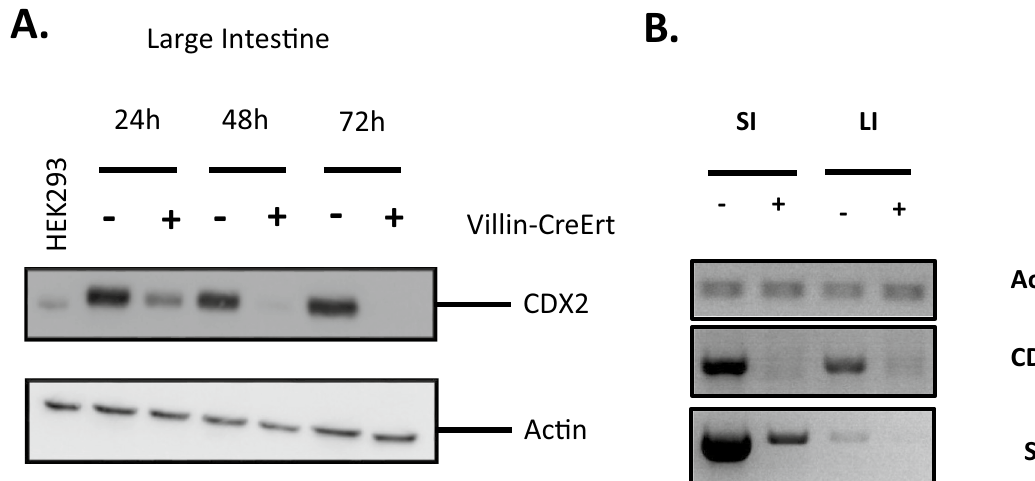
Figure 1. Characterization of Cdx2 conditional deletion. Mice were treated by oral gavage with 5 mg of tamoxifen dissolved in corn oil and intestinal cells collected at 24, 48 and 72 h. ( A ) Western blot illustrating loss of Cdx2. Actin was used as loading control and HEK293 cell lysates as a positive control for Cdx2. ( B ) RT-PCR analysis, using primers which flank the exon 1 and exon 2 boundary of Cdx2 , illustrates loss of Cdx2 and the Cdx-dependent gene Sucrase Isomaltase ( SIS ) at 48 h post-tamoxifen